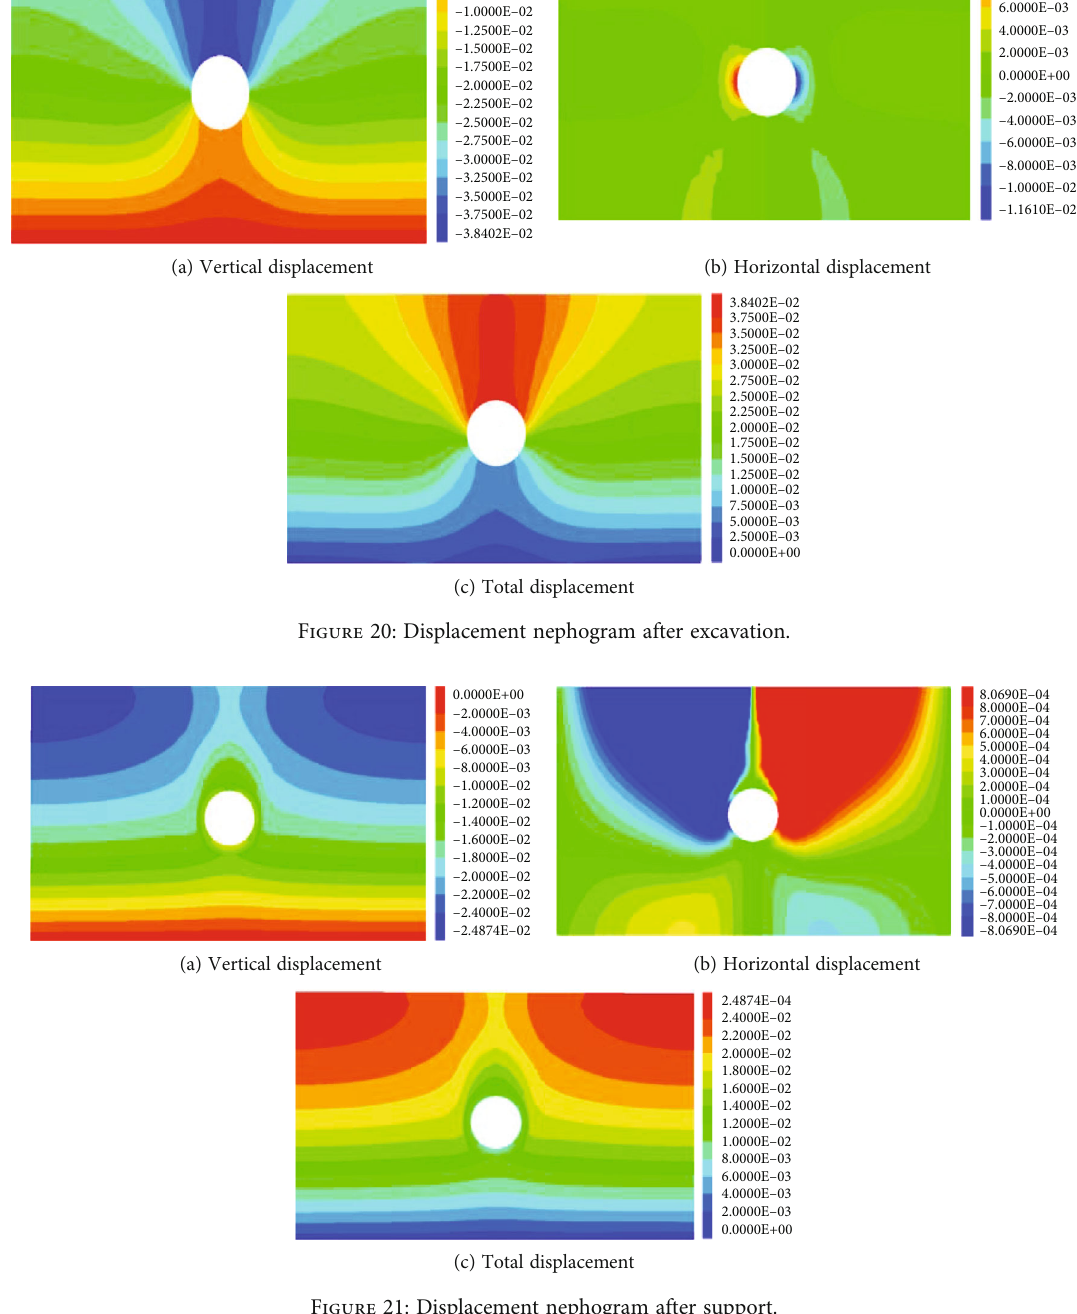
Figure 21: Displacement nephogram after